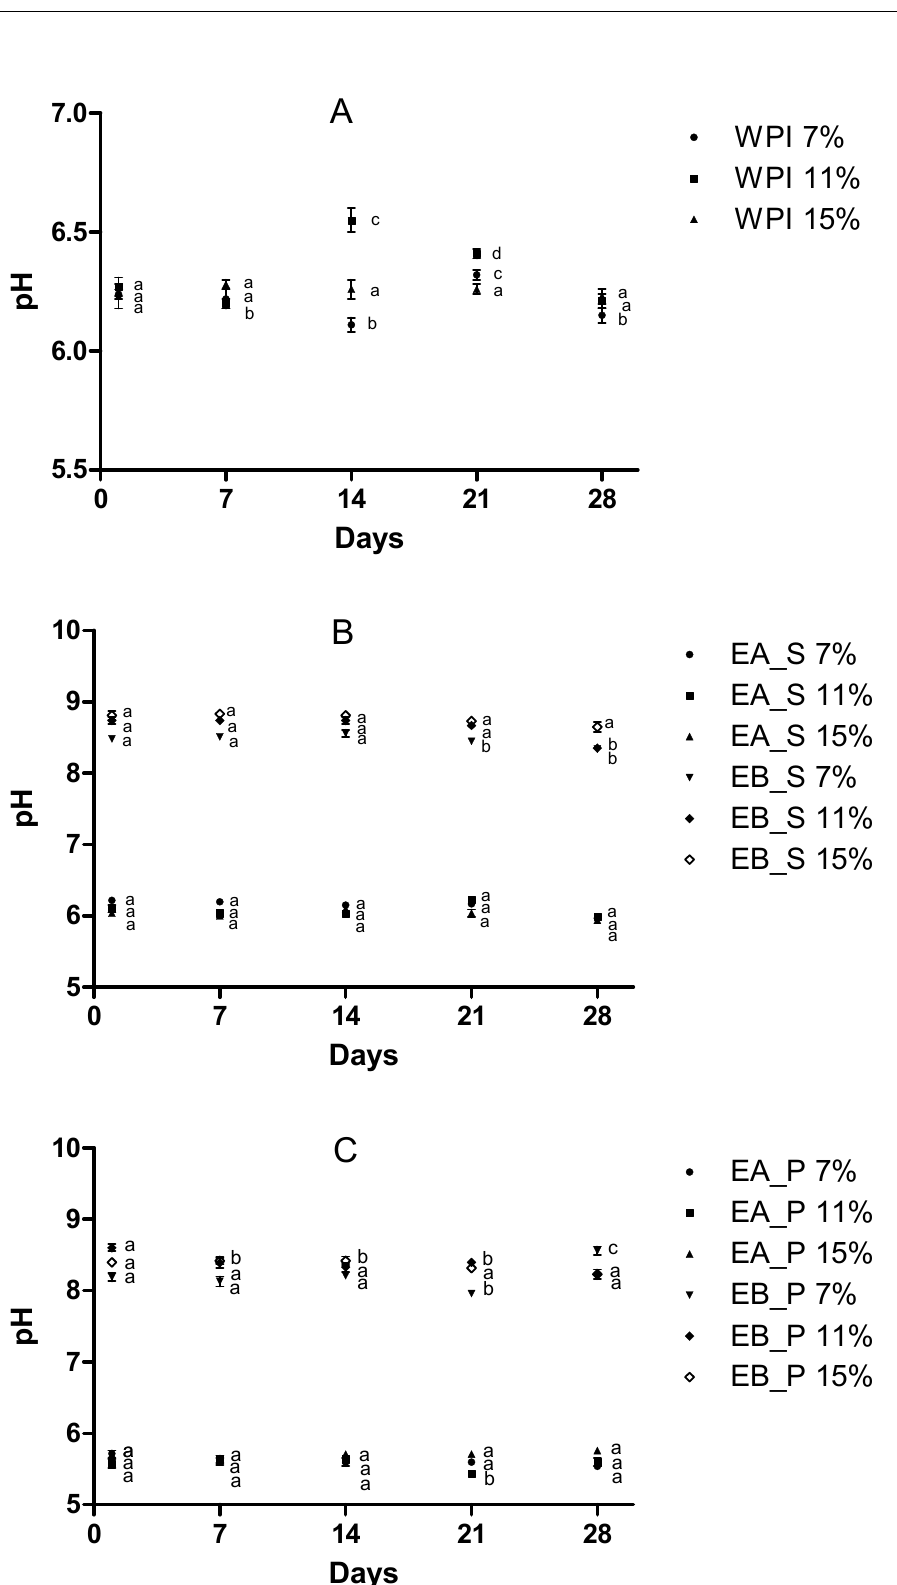
Figure 1. Effect of storage time on pH for WPI, soluble fraction and pellet from acid and alkaline extracted samples. Same letter means no significant differences for each substrate by days. ( A ) WPI = Whey protein isolate; ( B ) EA_S and EB_S = Soluble fraction from acid (EA) and alkaline (EB) extractions; ( C ) EA_P and EB_P = Pellet from acid (EA) and alkaline (EB) extractions. (Tables S5–S7 Supplementary Materials).